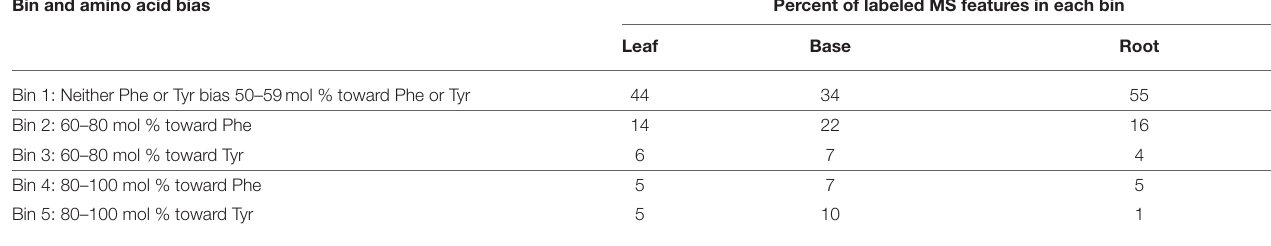
TABLE 1 | Categorizing labeled MS features derived from Phe and Tyr. Bin and amino acid bias Percent of labeled MS features in each bin